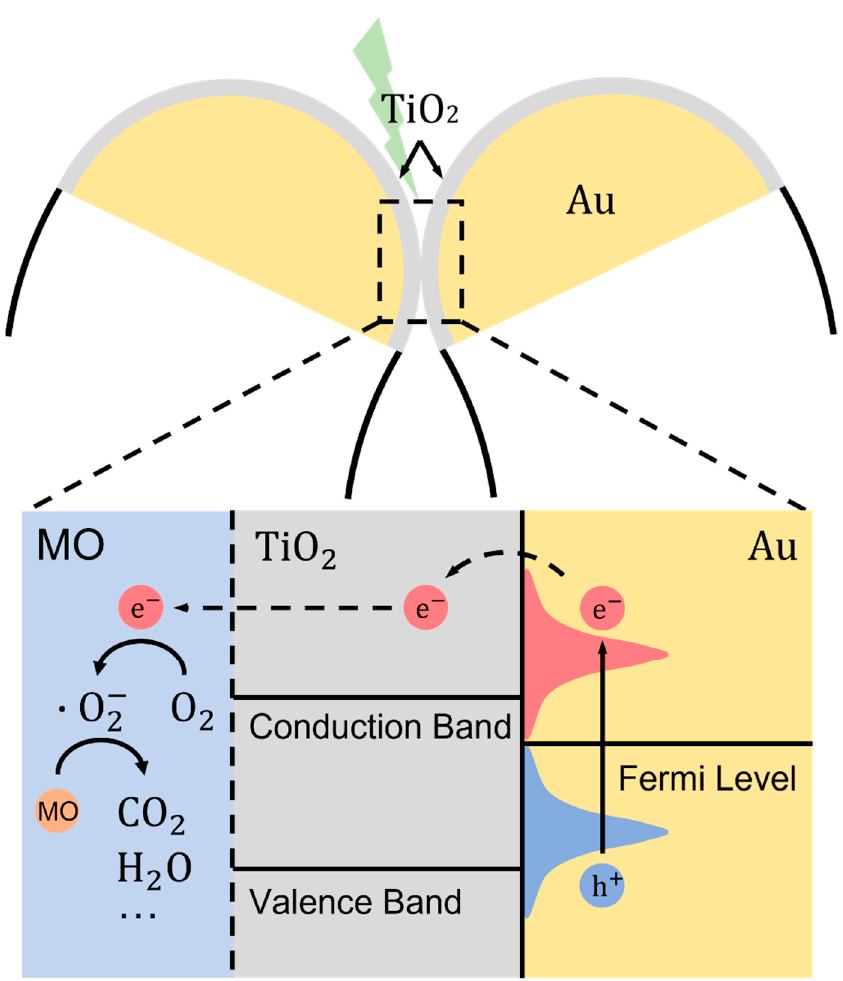
Figure 6. Illustration of the hot carrier-driven photocatalytic degradation of MO on collapsed nanofingers .